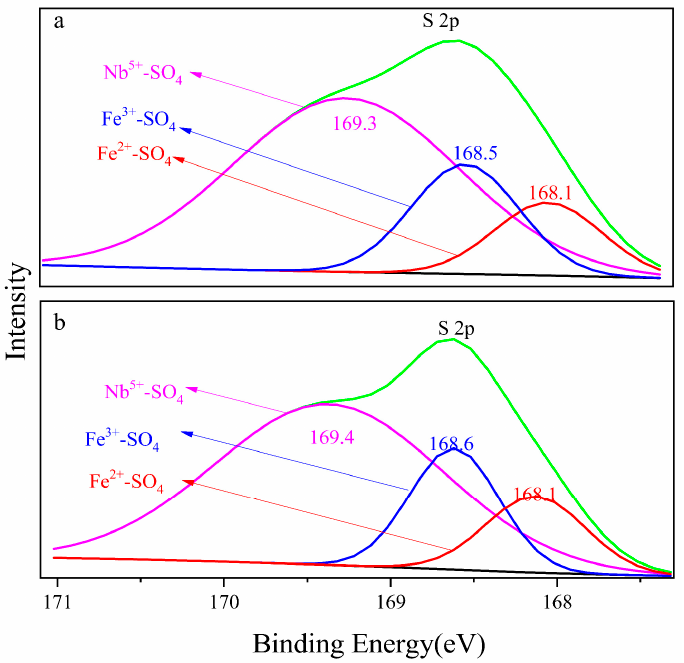
Figure 7. Electron binding energy of S 2p, ( a ) 8 M H 2 SO 4 acid leaching residue; ( b ) 12 M H 2 SO 4 acid leaching residue.